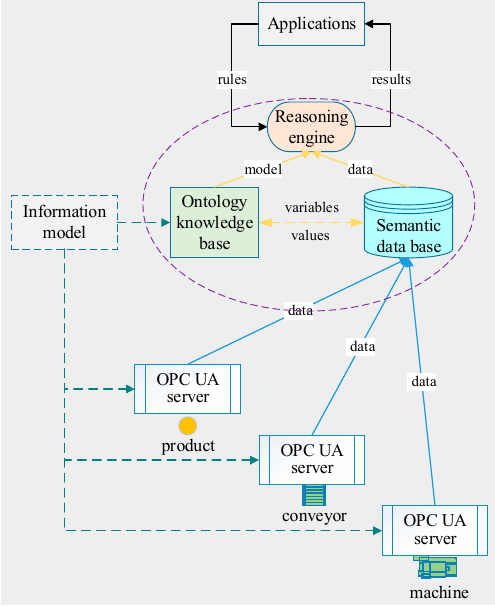
Figure 3. Integrated architecture of knowledge reasoning and semantic data.